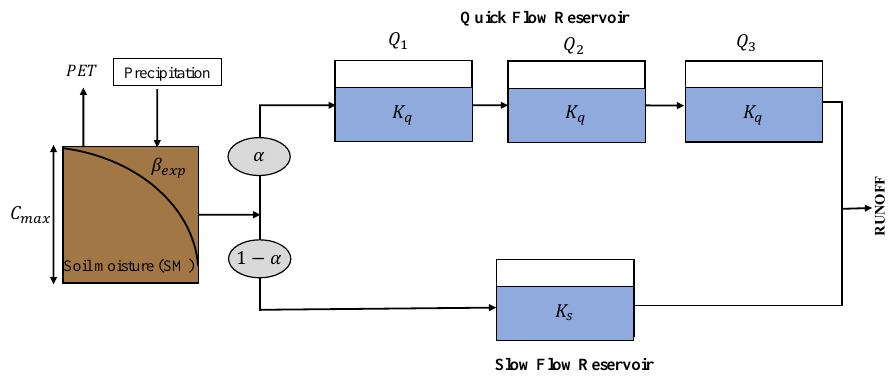
Figure 2. Conceptual diagram of the HYMOD